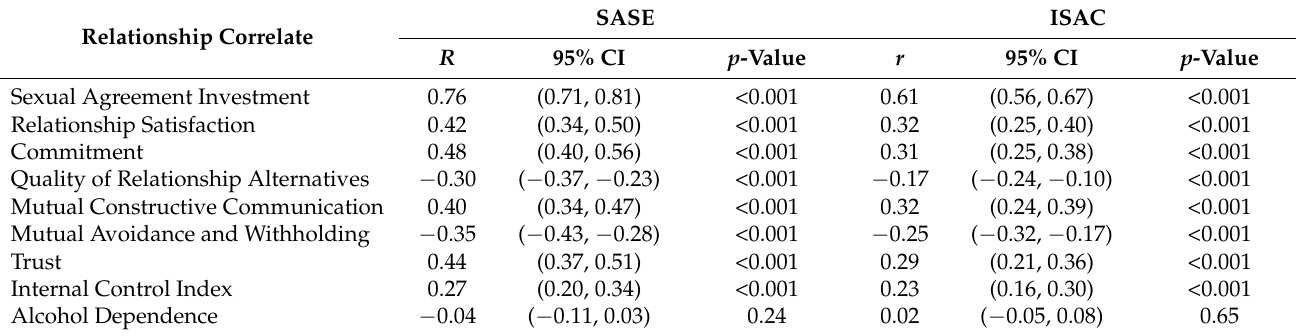
Table 5. Correlations ( r ) of SASE and ISAC with interpersonal relationship measures from Study